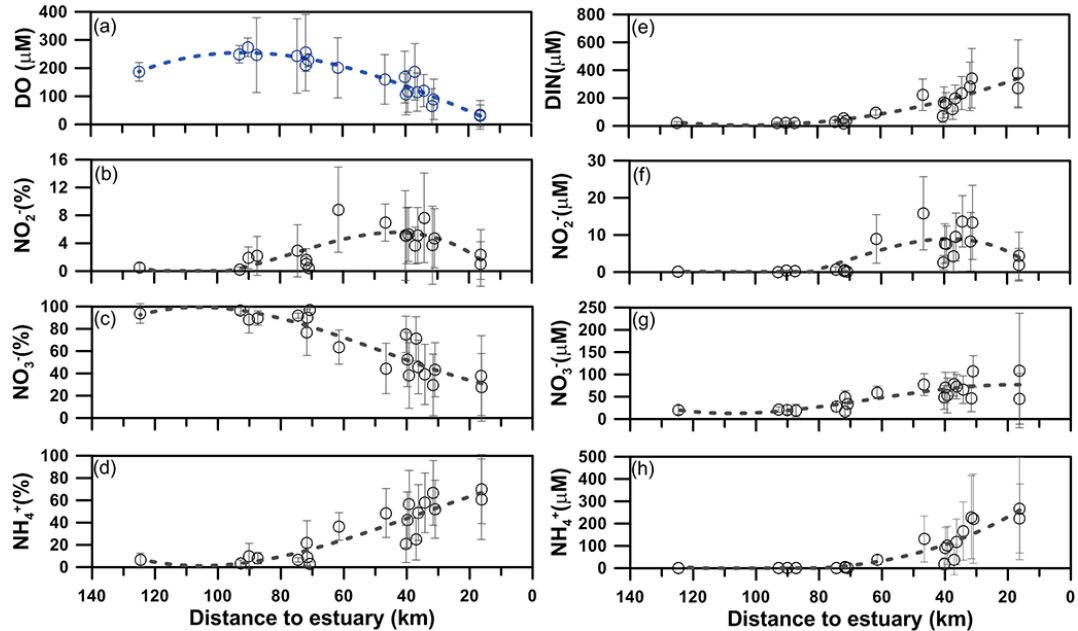
Figure 6. Longitudinal distributions of (a) dissolved oxygen, relative proportions of three DIN species, i.e. (b) nitrite, (c) nitrate and (d) ammonium, and concentrations of (e) DIN, (f) nitrite, (g) nitrate, and (h) ammonium along the Danshui River. Circles represent the mean of observations and bars are standard deviations. Dashed lines are polynomial fitting lines interpolating the trend along the